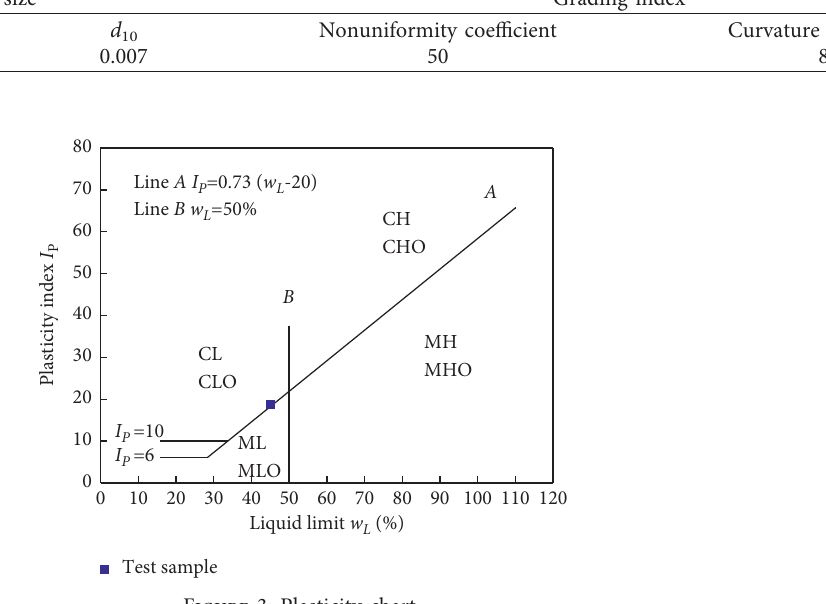
Figure 3: Plasticity